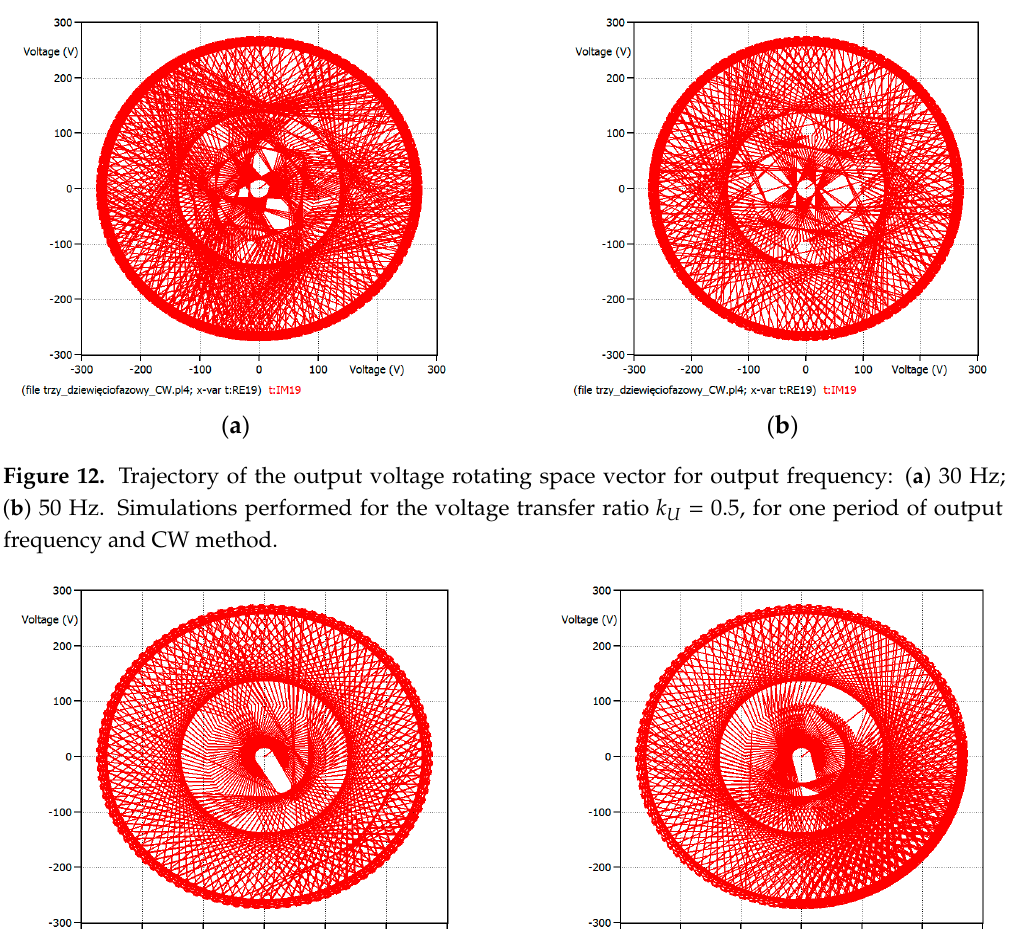
Figure 11. Trajectory of the output voltage rotating space vector for output frequency: ( a ) 30 Hz and ( b ) 50 Hz. Simulations performed for the voltage transfer ratio k U = 0.5, for one period of output frequency and CCW method.